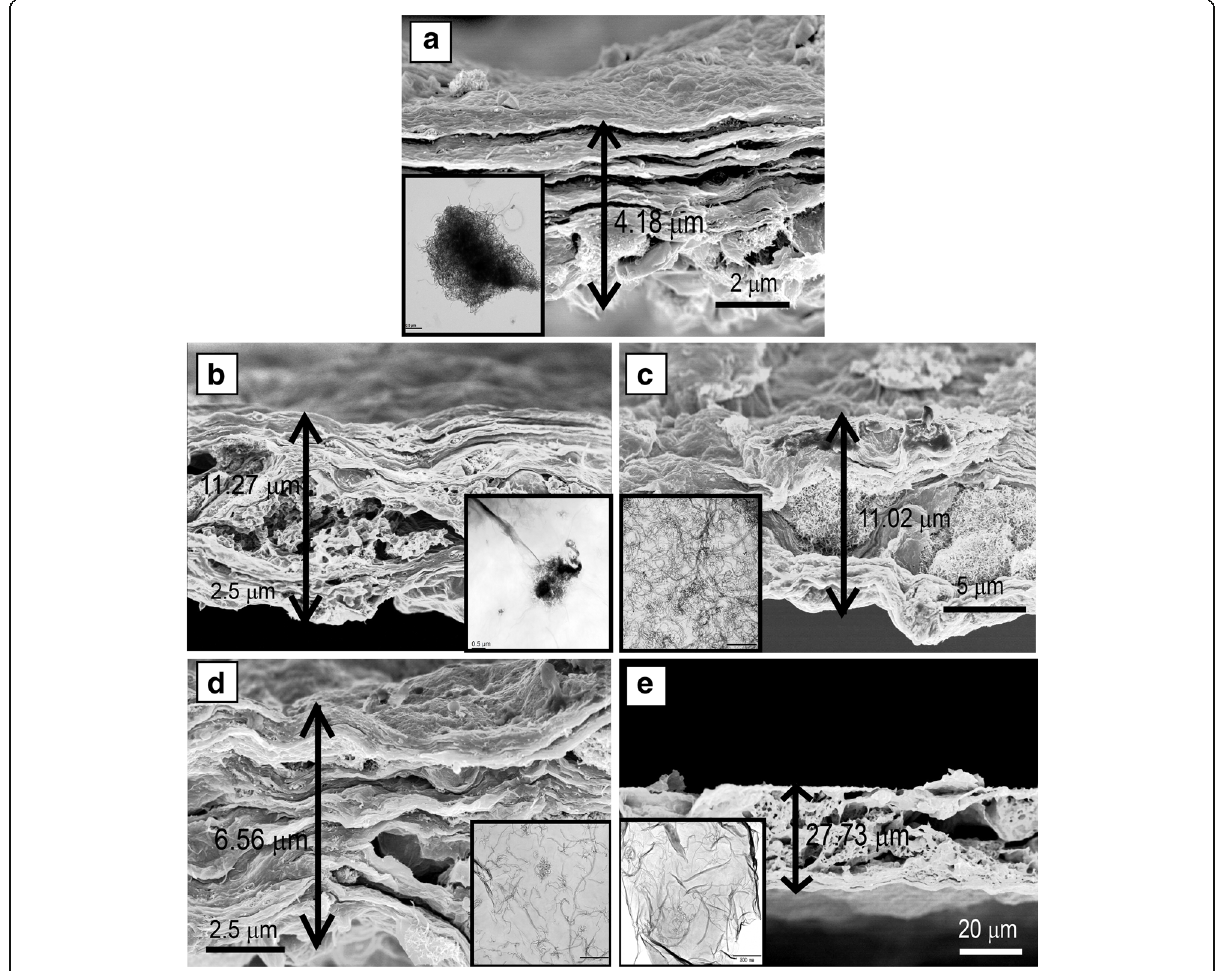
Fig. 3 a SEM images of cross-sections of the MWCNTs/GO membrane. b – e SEM images of the cross-sections of the MWCNTs/GO membrane; the inset shows TEM images. The concentration of PDDA is 0, 2, 5, 8, and 20 wt%,